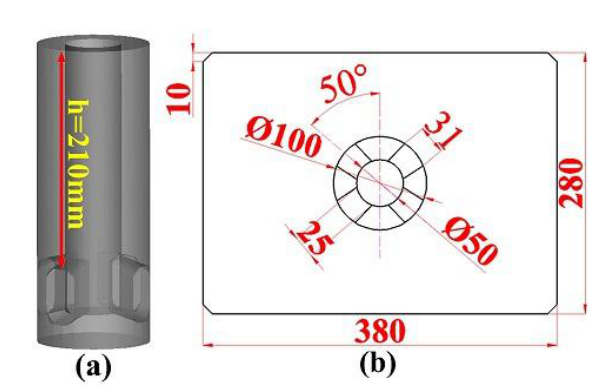
Figure 2. The three-dimensional view ( a ) and installation method ( b ) of submerged entry nozzle (SEN). Table 2. Industrial conductions for U71Mn